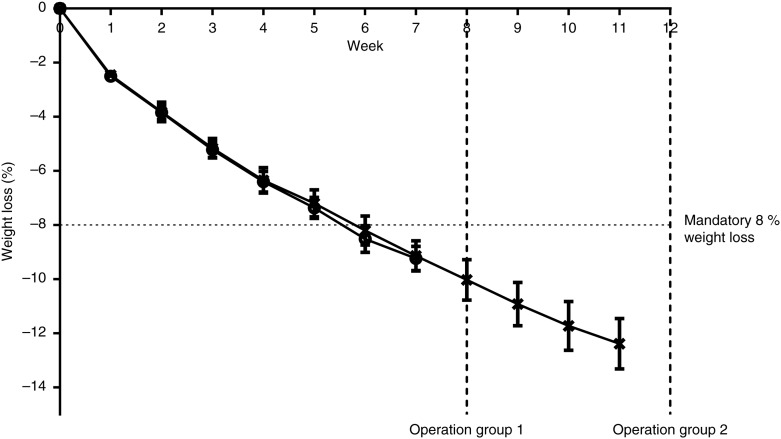
Weekly weight loss (%) measured from week 0 to 7 (n 30; groups 1 and 2; ○) and from week 0 to 11 in group 2 only (n 15; X). Group 1 were operated in week 8; group 2 was operated in week 12. Values are means, with standard errors represented by vertical bars.